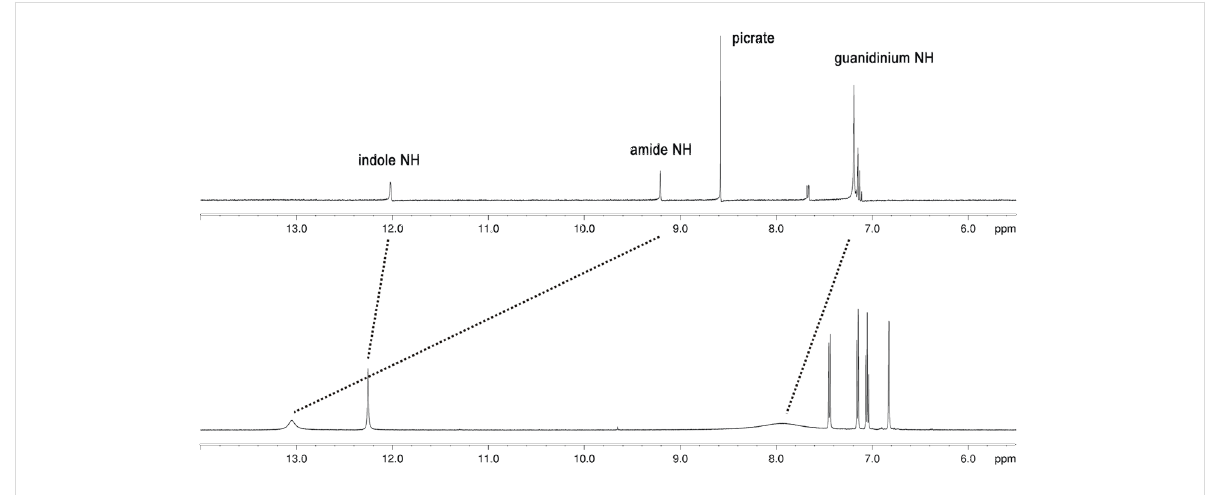
Figure 2: 1 H NMR spectra of zwitterion 2 (bottom) and its protonated form 2 · H + (top).